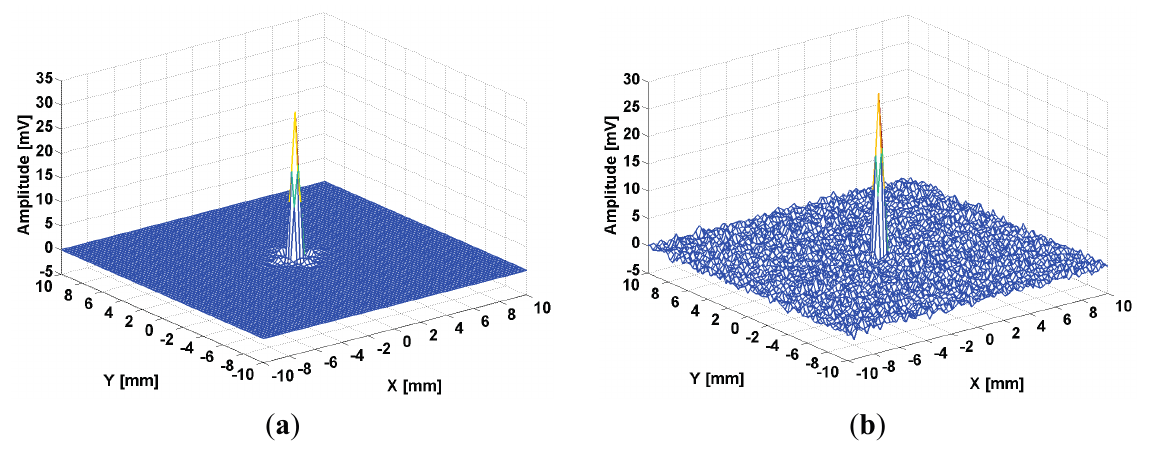
Figure 5. Point spread function for MM lens: ( a ) calculated; ( b )